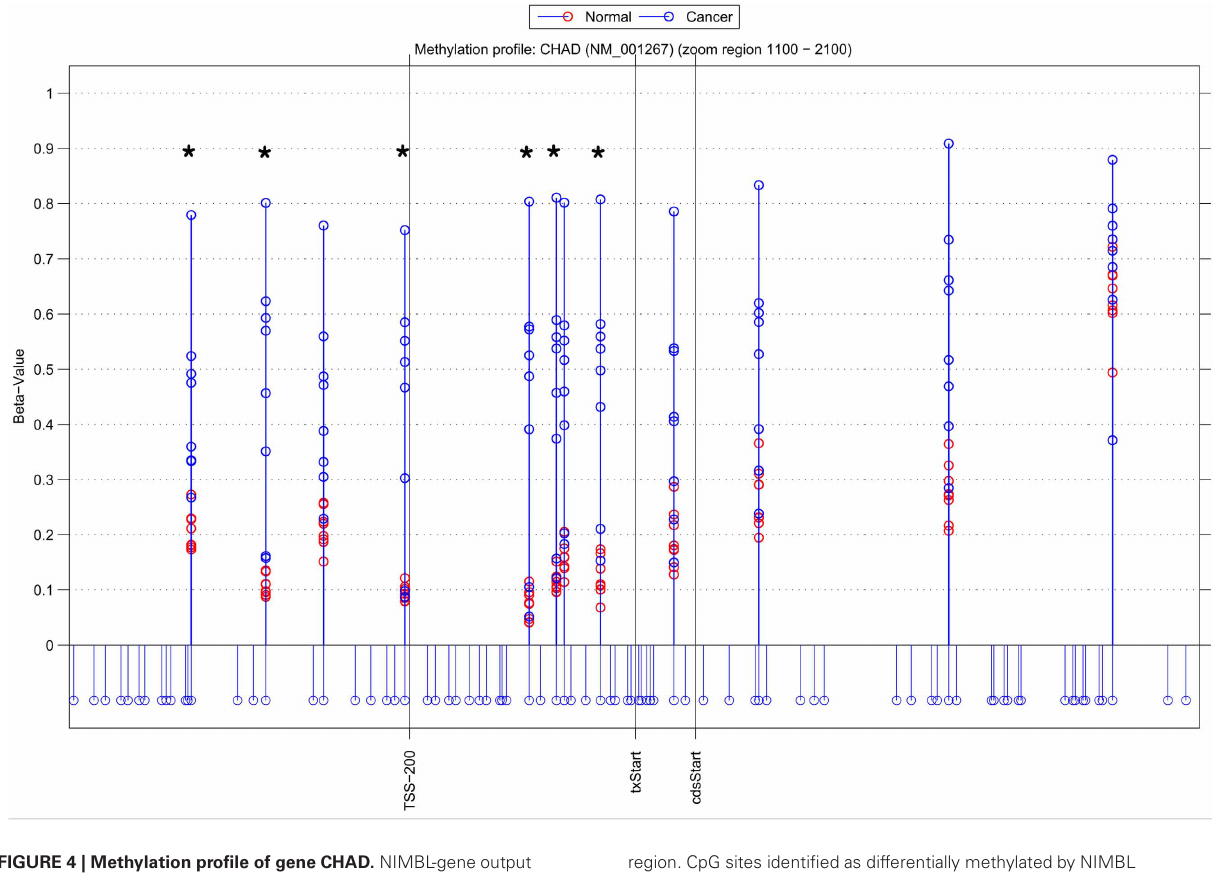
FIGURE 4 | Methylation profile of gene CHAD. NIMBL-gene output showing a zoomed region of the genomic location of the gene CHAD displaying 12 out of 14 CpG sites associated with this gene on the array. The stems below the x-axis correspond to all CpG sites located in this